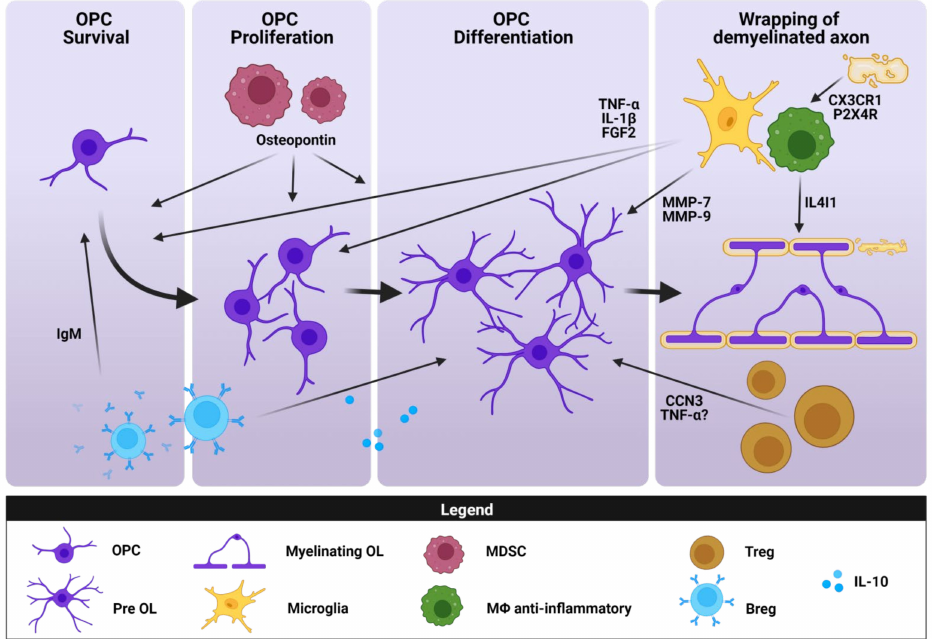
Figure 3. The role of immune regulatory cells in promoting remyelination. Immune regulatory cells contribute to the different phases of remyelination (OPC survival, proliferation, and differentiation towards mature OLs) by removing myelin debris (microglia/macrophages) or secreting various active molecules (microglia/macrophages, MDSCs, Treg) or even antibodies (Breg). Figure created with Biorender.com (accessed on 12 January